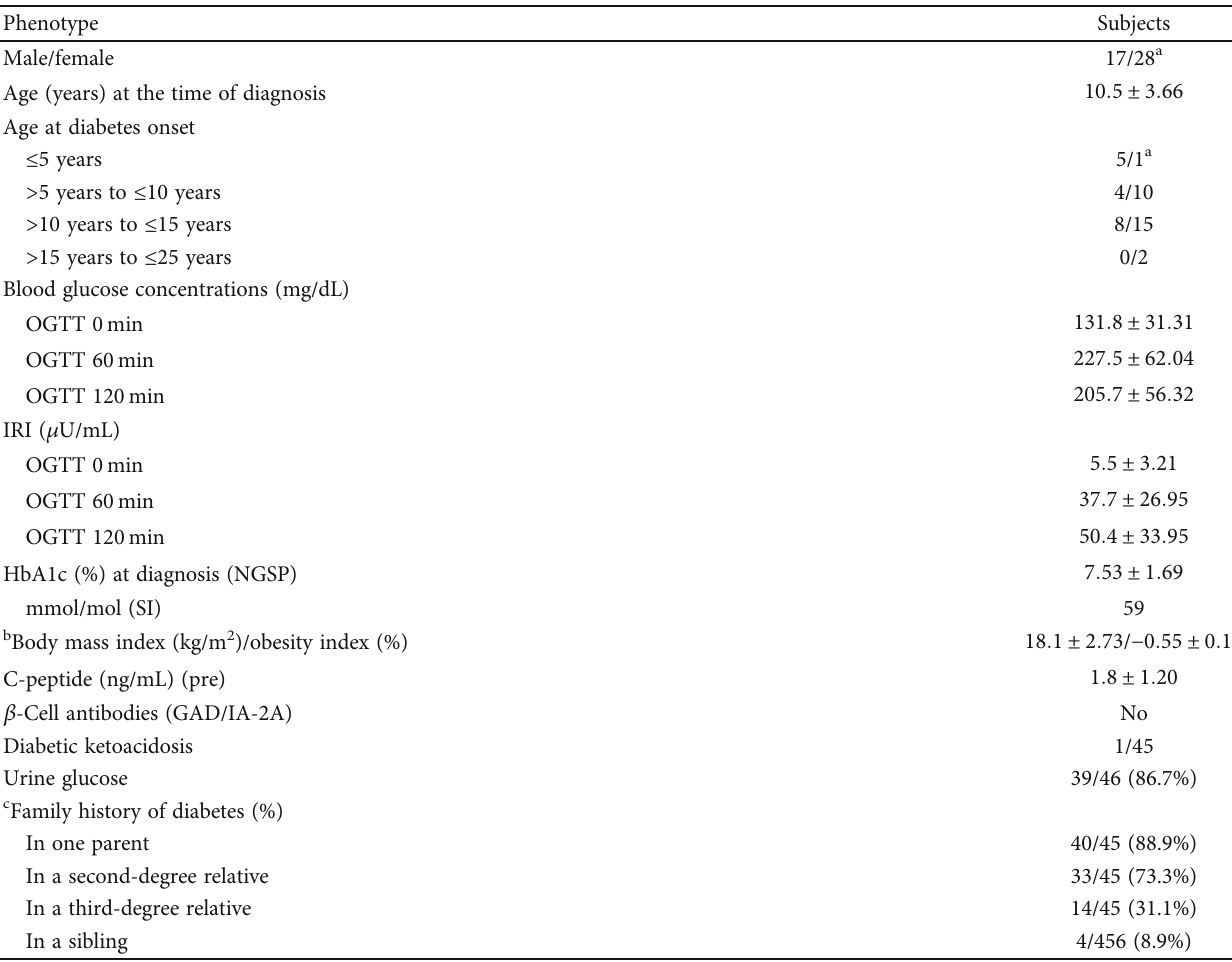
Table 1: Subject characteristics ( n = 45